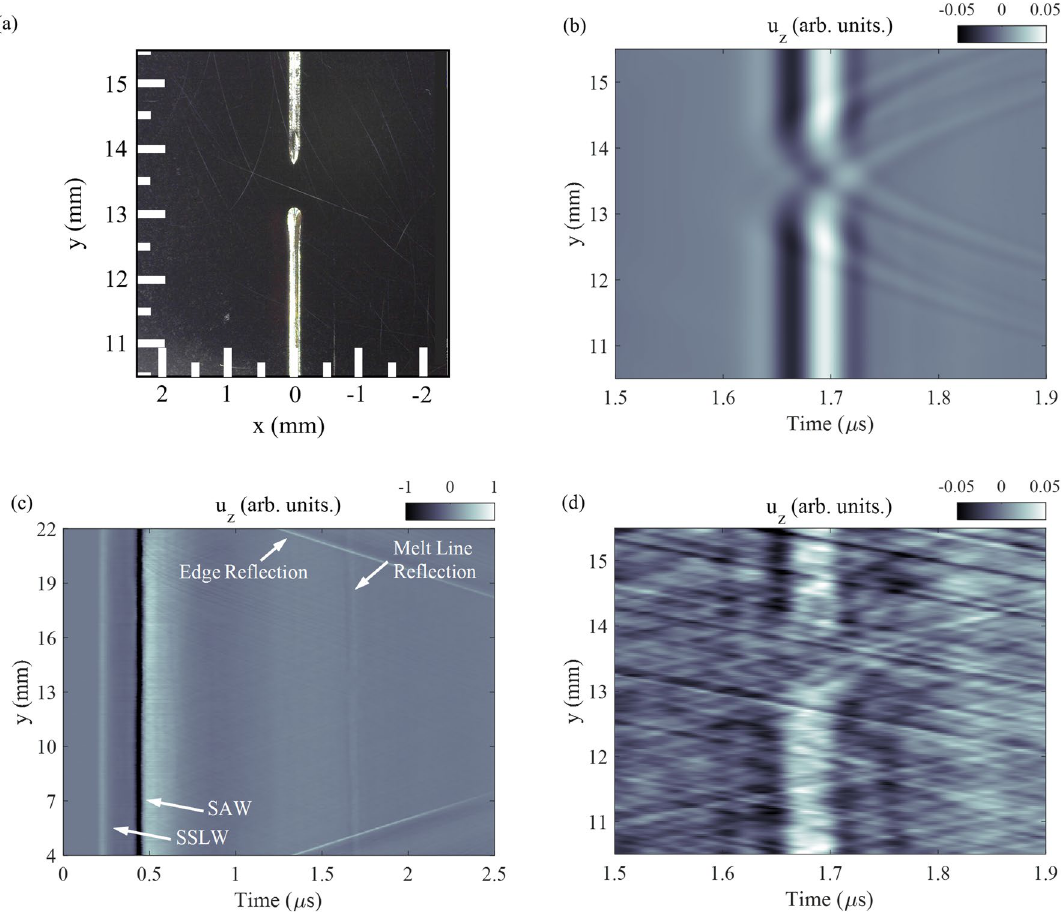
Figure 4. ( a ) Optical image of melt line. A break in the melt line is observed near y = 13 mm due to interruption of the beam by the edge of a razor-blade. ( b ) Simulation of displacement near break in the melt line. Parabolic scattering from the end and start of the melt line are observed as well as a gap in the planar reflection from the melt line. ( c ) Experimentally measured normal displacement while scanning along the y-axis of the sample. A break in the planar reflection from the melt line is apparent near y = 13 mm. ( d ) Magnified portion of the image in ( c ) showing parabolic scattering from the end of the melt line,faint parabolic scattering from the start of the melt line and the gap in the melt a 1 MHz HP filter. Figure 3b shows the measured reflection from the melt line is shown in detail. The time delay between the incident SAW and reflected signal (1.2 µ s) is consistent with twice the distance between the detec- tion and the center of the melt line (2 · 1.7 mm) divided by the SAW velocity ( c R ) 2.842 mm/ µ s. The measured reflection from the melt line is a SAW reflected from the incident SAW. Figure 3c shows the magnitude of the fast Fourier transform (FFT) of the incident SAW after time windowing the signals in Fig. 3a from t = 0.37–1.0 µ s with a Tukey (tapered cosine) window with a cosine fraction ( r ) of 0.2. The incident SAW is broadband in frequency. Figure 3a–c demonstrate excellent agreement between simulation and experimental measurement of the laser-based SAW system. Three Ti-6Al-4V samples were created with different melt laser powers. First, a Ti-6Al-4V sample was created with a melt laser power of 100 W with a small break in the melt line to assess the laser-based SAW system sensi- tivity to defects in the melt line. The sample was created using the previously-described configuration; however, a razor blade was placed such that the thin edge of the blade obstructed the melt laser. An optical image of the sample near this location is shown in Fig. 4a where an approximately 0.75 mm break in the melt line is clearly observed near y = 13 mm. At the start of the break, the melt line terminates in a half sphere, whereas at the end of the break the melt line starts with an arrow shape. The sample was measured using the previously-detailed laser-based SAW setup. The part was scanned from y = 4–22 mm in 25 µ m steps. A second Ti-6Al-4V sample was created with a melt laser power of 150 W with a single continuous melt line, as shown in Fig. 1c, and the configuration previously described. The surface of the sample was measured using structured light 55 . After measurement by the laser-based SAW setup, the sample was sectioned at x = ± 1.5 mm and z = 1.5 mm, resulting in a 3.0 × 25.4 × 1.5 mm 3 (x, y, z) sample for X-ray CT. A third Ti-6Al-4V sample was created with a melt laser power of 350 W with a single continuous melt line, as shown in Fig. 1c. First the sample melt line topology was measured with structured light; then the sample was